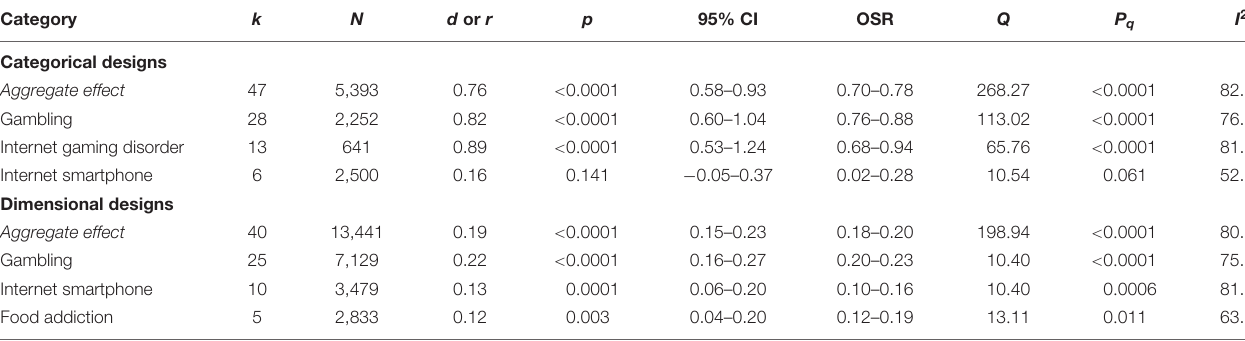
TABLE 1 | Meta-analytic